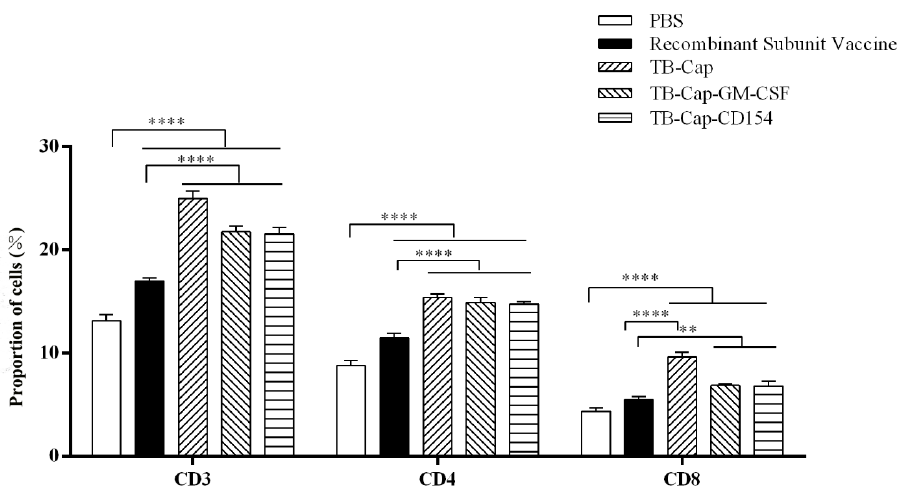
Figure 6. Lymphocyte proliferation levels in different groups. On day 42 after the first immunization, lymphocytes were collected and the proliferation was detected by CCK-8. The stimulation index (SI) = (mean OD 450 nm of PCV2 stimulated cells − mean OD 450 nm of negative control cells)/(mean OD 450 nm of positive control cells − mean OD 450 nm of negative control cells). Data represent the mean ± SD. An asterisk (*) shows a statistically significant difference between the indicated groups ( p < 0.05). (*): p < 0.05; (**): p < 0.01; (***): p < 0.001; (****): p < 0.0001.